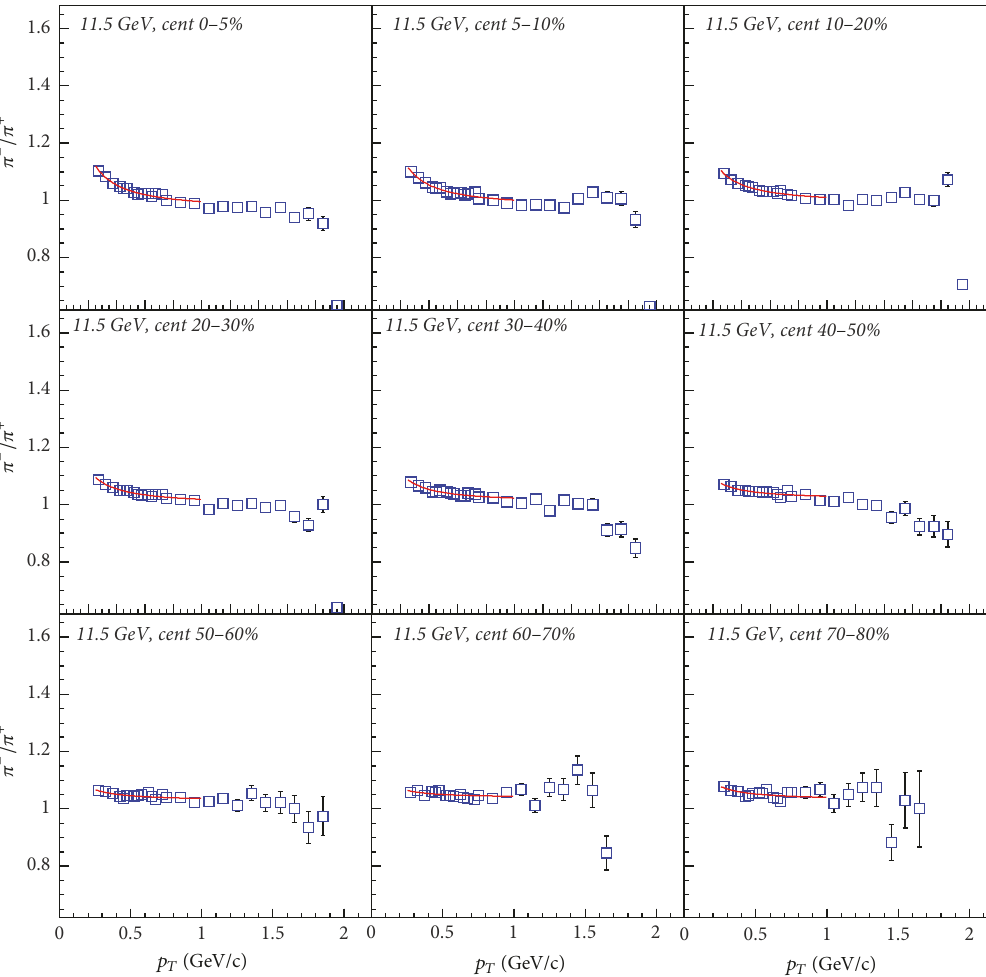
Figure 2: The 𝜋 − /𝜋 + ratios produced in Au+Au collisions at 11.5GeV as a function of transverse momentum. The data are from [14]. The red lines are the fits to the ratio data using